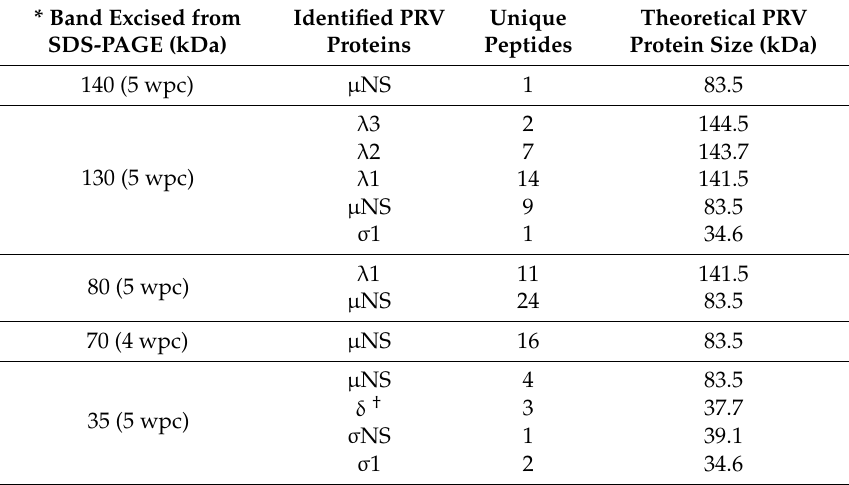
μ NS and mass spectrometry (MS). 419